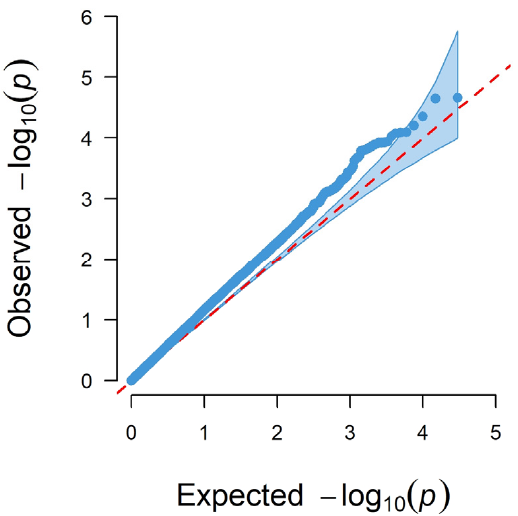
Figure 6. Manhattan plot representing genome-wide associations with logFEC using the 50K SNP chip and 375 genotyped individuals. Y -axis shows each SNP -log 10 ( p -value) and x -axis shows the SNP position across the 26 chromosomes. Green dots represent the significant SNPs using a chromosome-wise FDR of 5%, black and gray dots are non-significant SNPs.